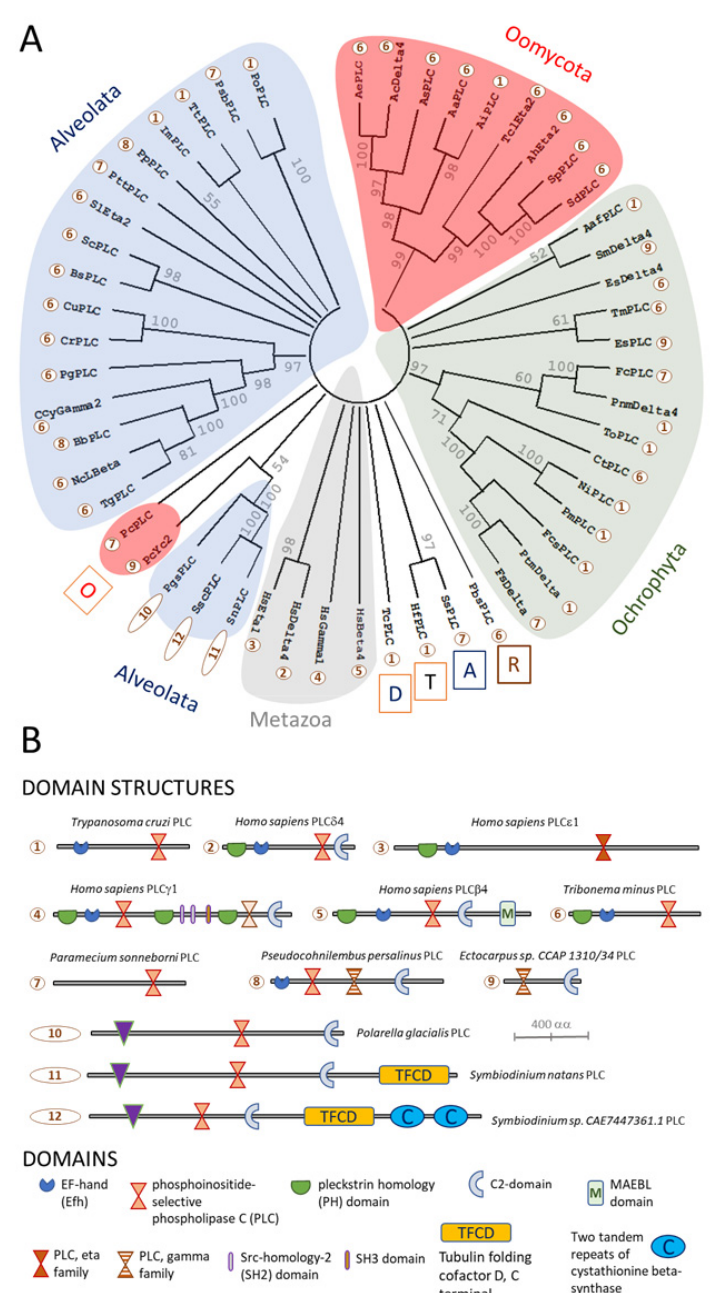
Figure 3. Phylogeny and protein domain architectures of PI-PLC proteins from members of the Stramenopile-Alveolate-Rhizaria (SAR) group. Panel ( A ) shows a reconstruction of the evolutionary history of candidate PI-PLC homologues inferred from Maximum-Likelihood analyses, using the JTT model [69] with 500 bootstrap replicates [70]. Branches that were reproduced in less than 50% of the bootstrap replicates were collapsed (node information indicates the % of replicates). This analysis used 53 amino acid sequence, with 3274 positions in the final dataset, and was conducted using MEGA11 software [71]. Letters in boxes represent taxonomic groups: A, alveolates; D, discobans; O, oomycetes; R, rhizarians; and T, thraustochytrids. For species names, see Table S2. Numbers within circles represent protein domain architectures. Panel ( B ) shows these different types of architectures, which are shown approximately to scale. Additionally, shown is a key to protein domains.